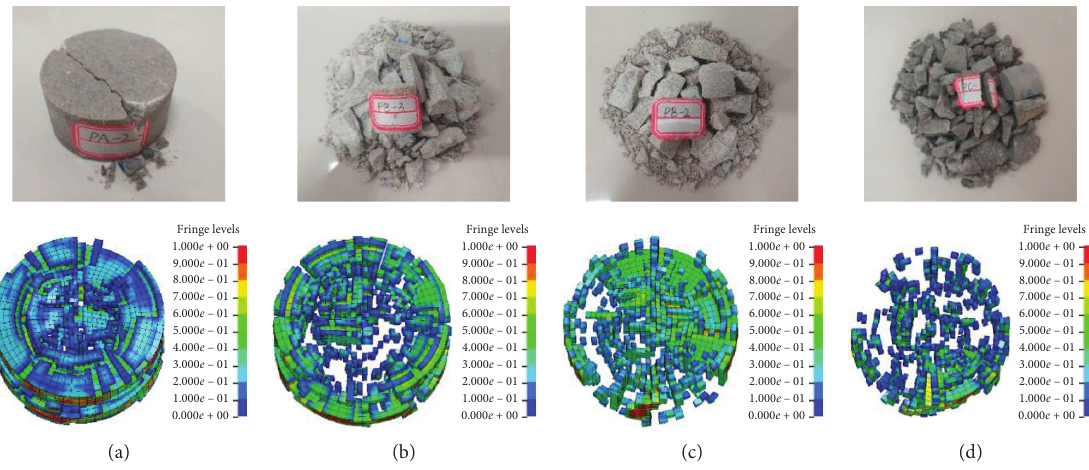
Figure 7: Rock failures under impact compression. (a) _ ε � 271 . 4 (b) _ ε � 334 . 2 (c) _ ε � 412 . 5 (d) _ ε � 501 . 6.